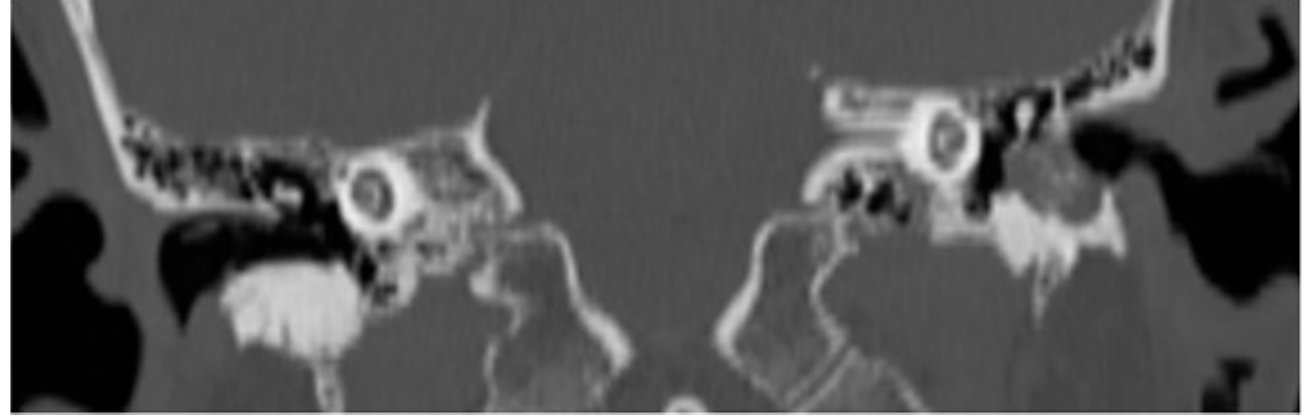
Figure 6. Patient 3, CT scan: evidence of soft and erosive tissue on the anterior wall of the left EAC. The lesion, causing erosion of the anterior wall of the EAC and extension to adjacent TMJ without complications, was staged as IIIa, according to the classification of HN et al. [1] (corresponding to bone erosion—stage III reported by Naim et al. [2]). The patient underwent the removal of the erosive lesion and the peri-wound tissue through TEES, using a rigid endoscope with a 3 mm diameter and 0° viewing angle, after which a reconstruction with fascia was performed.